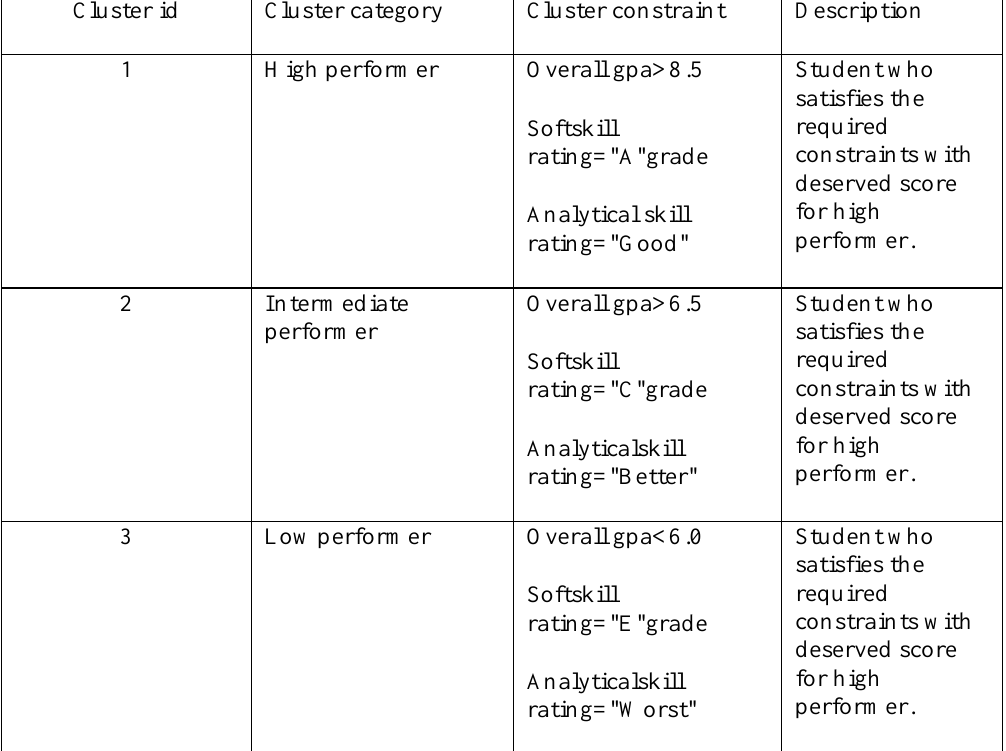
Clusters Formed Using K-Means Algorithm Cluster id Cluster category Cluster constraint Description High